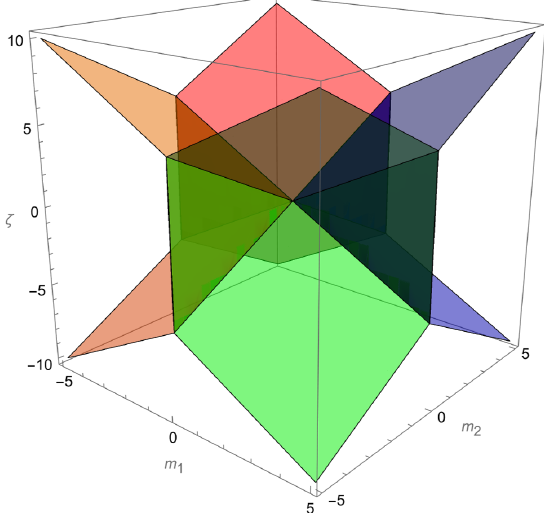
Figure 3 . The regions of validity for the six pairs of holomorphic blocks of the SQED 2 model. The top and bottom regions ( R (rear-facing) quadrant ( R (front-facing) one ( R